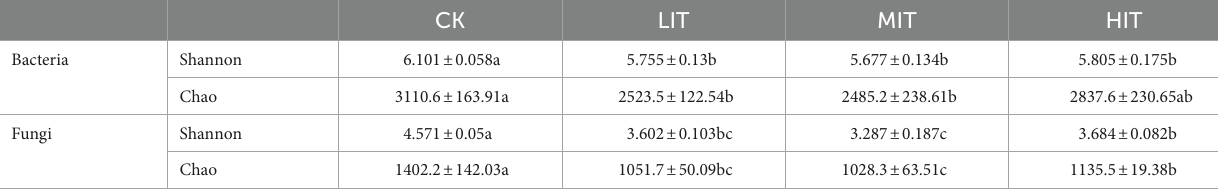
TABLE 3 Diversity indices of the bacterial and fungal communities among the four thinning treatments in C. japonica var. sinensis plantations.